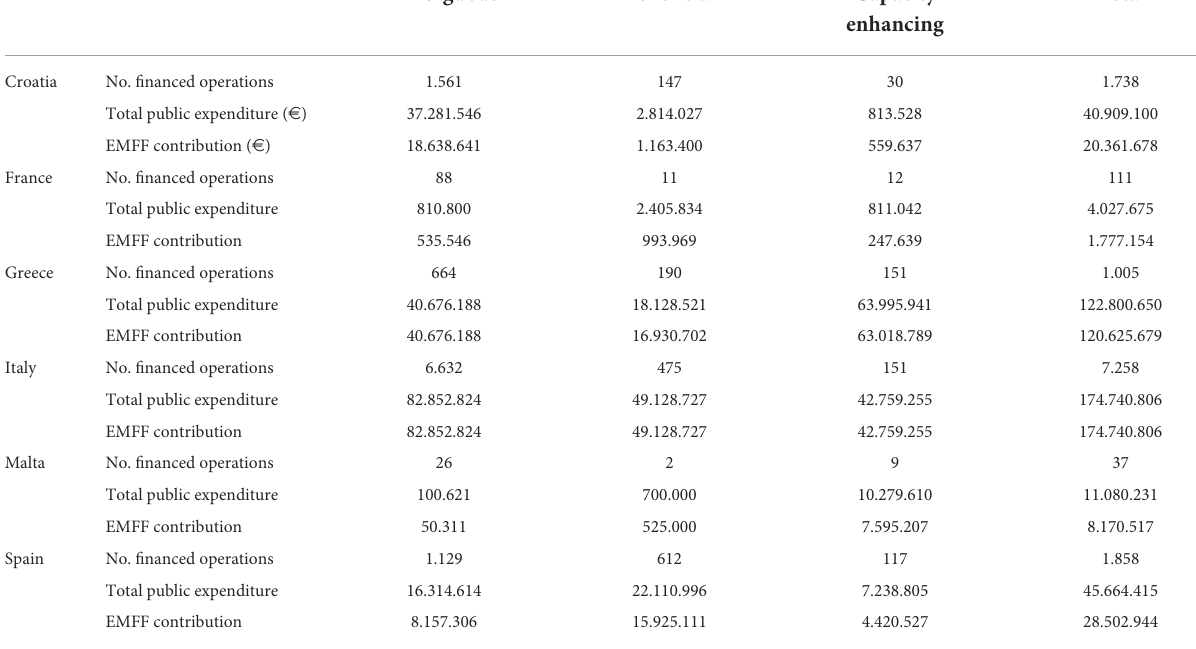
TABLE 5 Number of financed operations, total public expenditures and EMFF contributions by MSs and subsidy